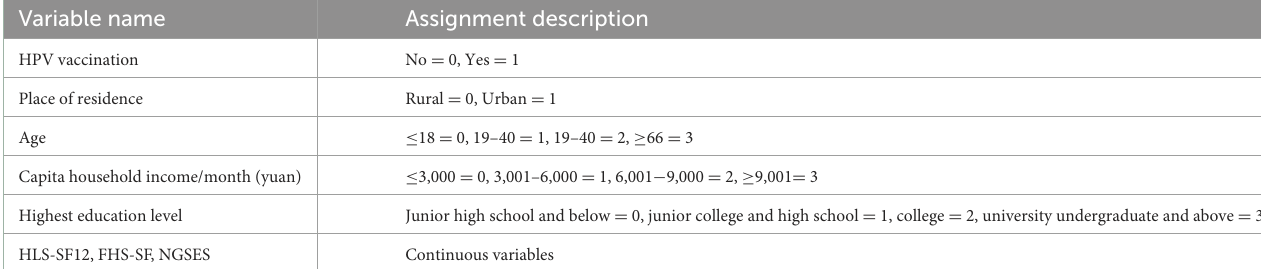
TABLE 2 Variables and dummy variables assignment